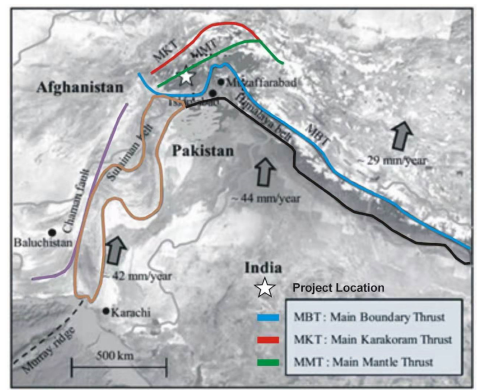
Figure 1. General tectonic setting of Pakistan and tectonic plates movements [3]. The major faults along with active belts surrounding the project are